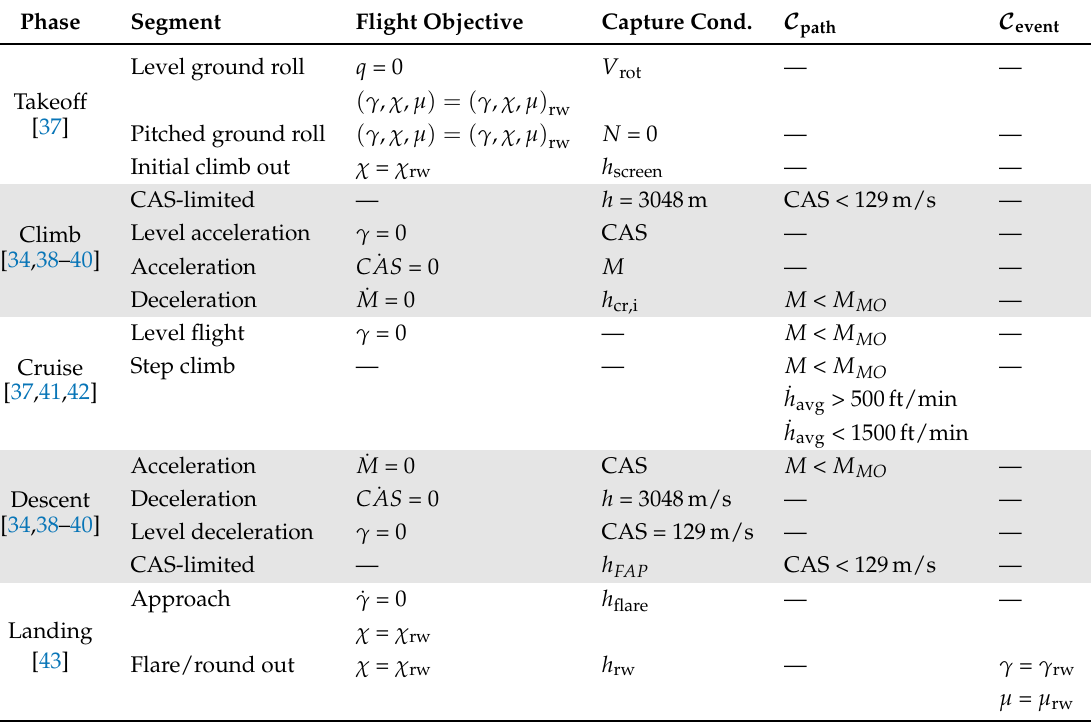
Table 2. Mission phase stereotypes synopsis.